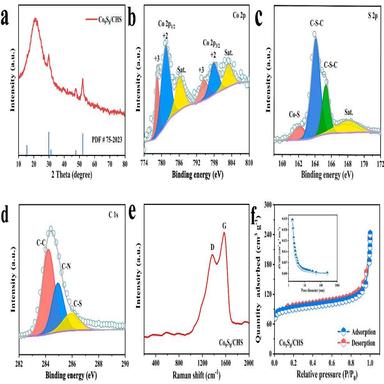
(a) XRD patterns of Co9S8/CHS; XPS spectra of (b) Co 2p, (c) S 2p and (d) C 1s for Co9S8/CHS; (e) Raman spectrum of Co9S8/CHS; (f) N2-sorption isotherms (inset: pore-size distribution) of Co9S8/CHS.